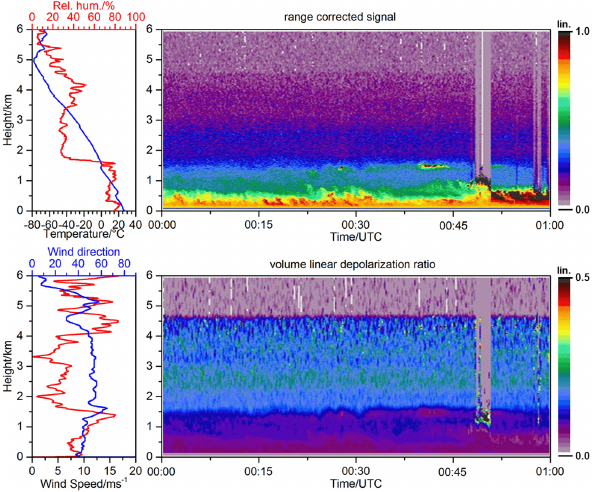
Figure 10. Same as Fig. 4 but for 11 July 2013, 23:00–24:00UTC. The radiosonde was launched on 11 July at 23:26UTC.